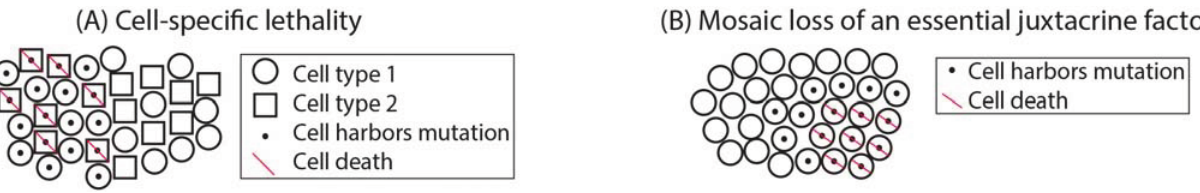
Figure 3. Cell death may reduce the total number of cells harboring somatic mutation. Mosaic mutations may cause cell-type-specific lethality ( A ); Mosaic loss of an essential juxtacrine signaling factor may cause localized death of cells that are not adjacent to unaffected tissues ( B